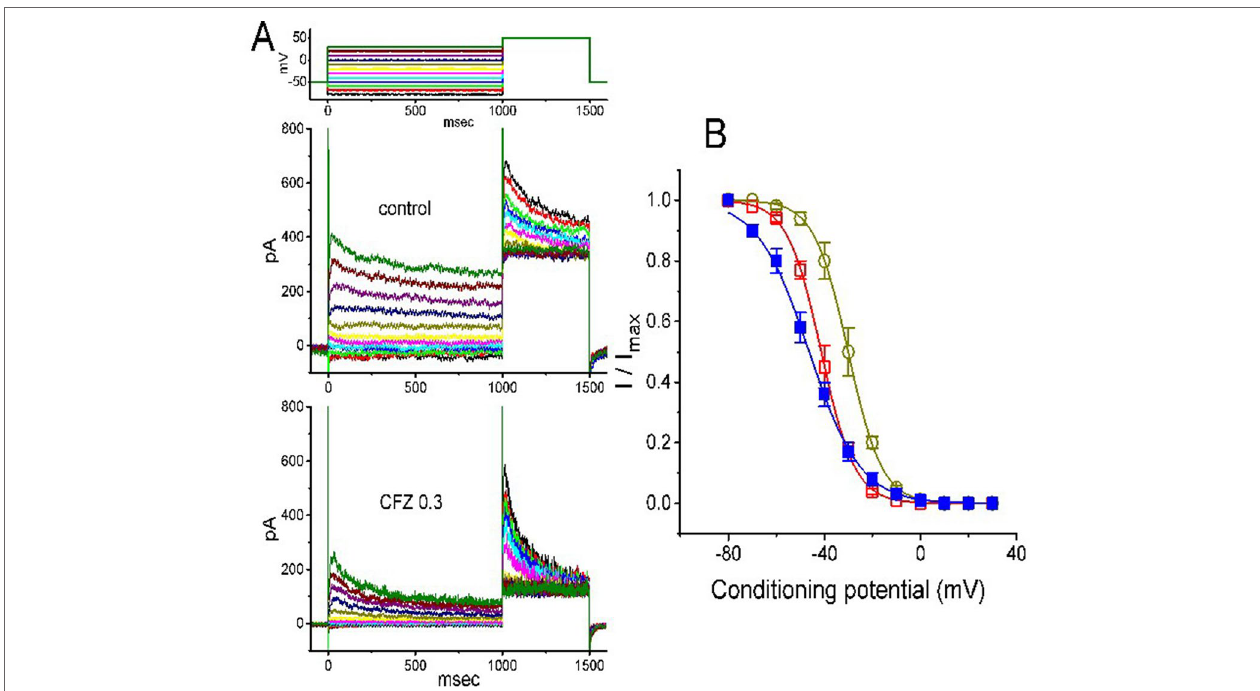
FIGURE 3 | Effect of CFZ on the steady-state inactivation of I K(DR) in GH 3 cells. (A) Representative I K(DR) traces obtained in the absence (upper) and presence (lower) of 0.3 µ M CFZ. As the examined cell was held at −50 mV, the conditioning voltage pulses with a duration of 1 s to various membrane potentials ranging from −80 to +30 mV were delivered. Following each condition pulse applied, a test pulse to +50 mV with a duration of 500 ms was then applied to elicit I K(DR) . The upper part indicates the voltage protocol used. (B) Steady-state inactivation curve of I K(DR) in the absence (filled squares) and presence of 0.3 µ M (open circles) and 1 µ M (open squares) CFZ (mean ± SEM; n = 8 for each point). The smooth curves were least-squares fitted by a Boltzmann function (detailed under Materials and Methods ).